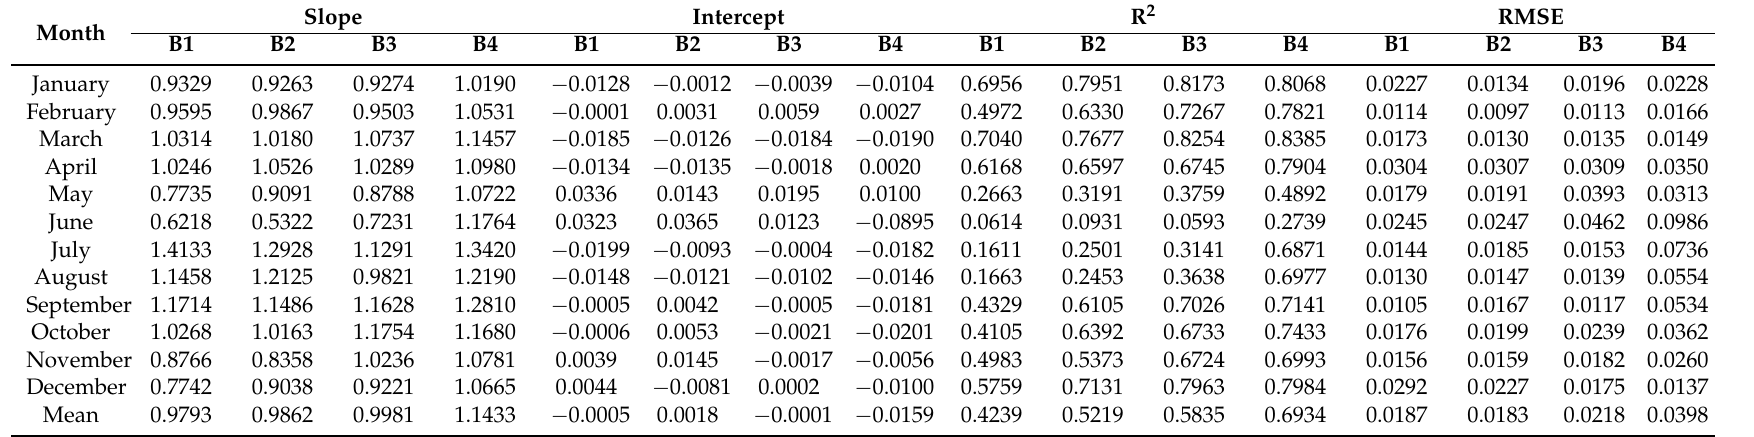
Table 2. Comparison of TOA reflectance for the HJ-1A/B monthly composites and WELD global monthly composite